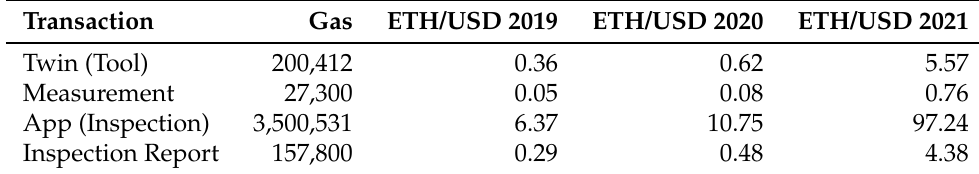
Table 5. Estimated transaction costs (expressed in USD) using different ETH/USD based on histori- cal prices.